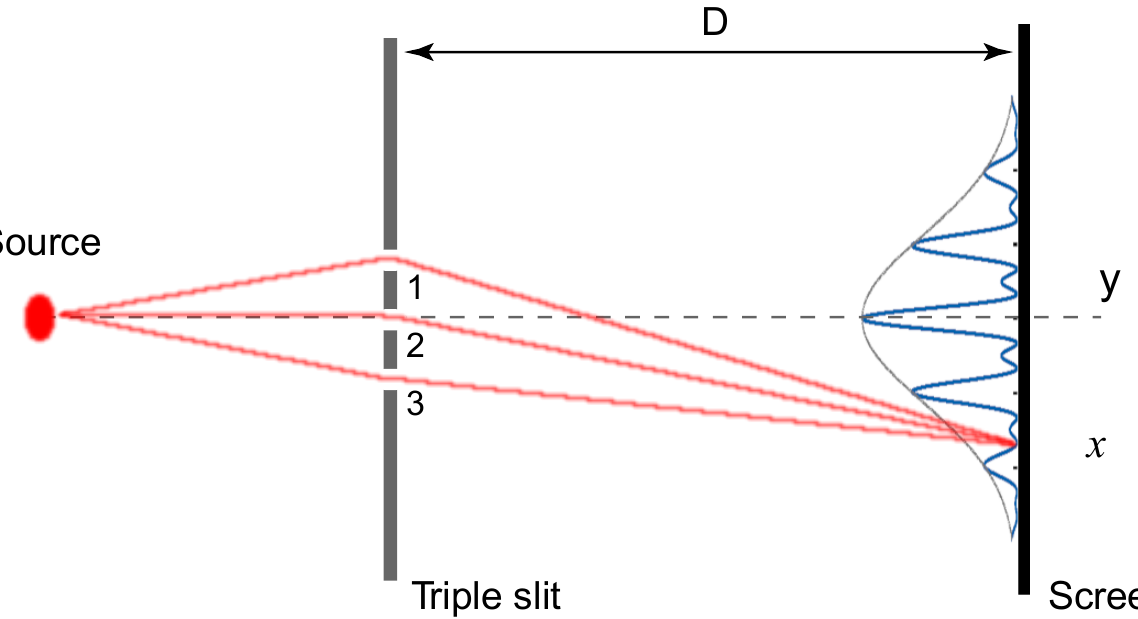
Figure 2: Schematic diagram of a three-slit interference experiment. There are three possible paths a quanton can take, in arriving at the